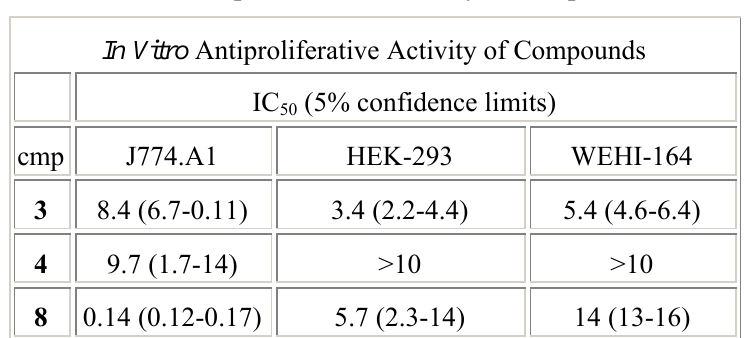
Table 3. Antiproliferative activity of samples 1-11